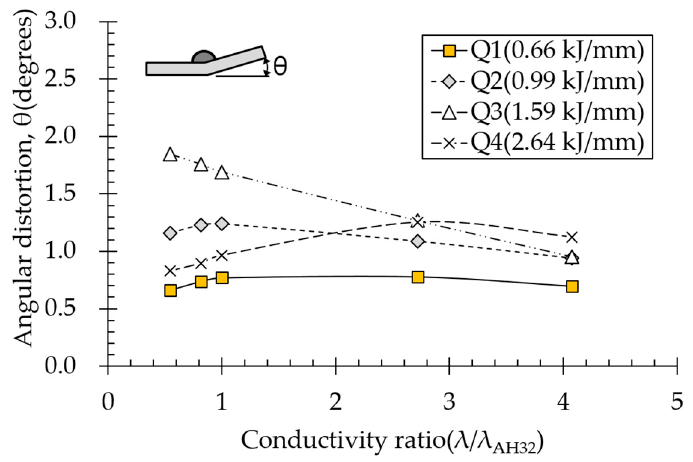
Figure 13. E ff ect of thermal conductivity on angular Figure 13. Effect of thermal conductivity on angular distortion.